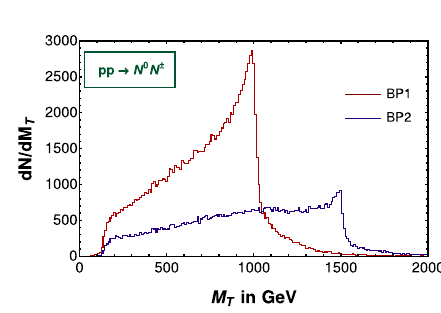
Figure 17b present the cross-section for μ + μ − → N + N − with respect to centre of mass energy for the two benchmark points. It can be seen that the off-shell cross-sections drop very quickly, which implies very high energy is not efficient